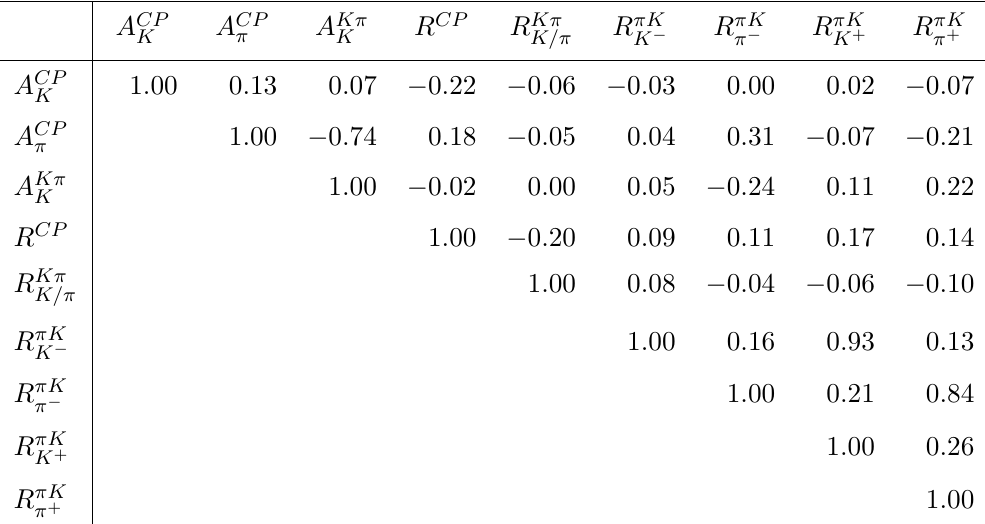
Table 6 . Systematic correlation matrix for B ± → Dh ±